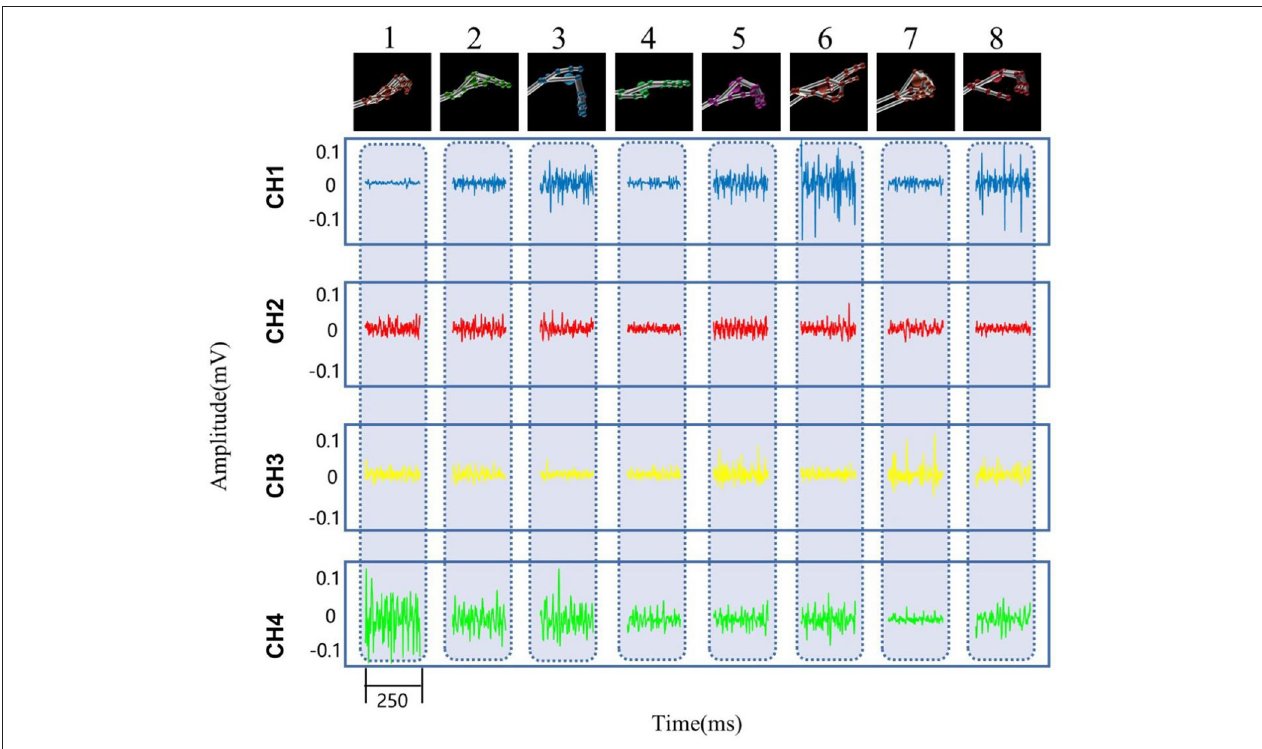
FIGURE 5 | Representative EMG and kinematic data of eight hand patterns recorded from one subject. Patterns 1–8 are: finger bend, finger close, finger flexion, hand open, lateral pinch, fingertip to fingertip, fist, and cylindrical grip, respectively. The top row kinematic data are recorded from Leap motion. The EMG data of CH1–CH4 are recorded from muscles of abductor pollicis brevis, flexor carpi radialis, extensor digitorum, and extensor carpi ulnaris,